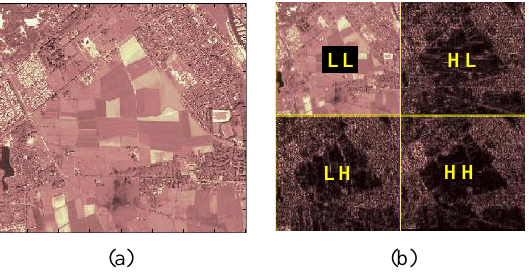
Figure 2. Examples of some common wavelet functions, ψ ( t ). (a) Daubechies wavelet of order 1 ( db1 ), also called the Haar wavelet. (b) Symlet wavelet of order 2 ( sym2 ). (c) “Mexican hat”